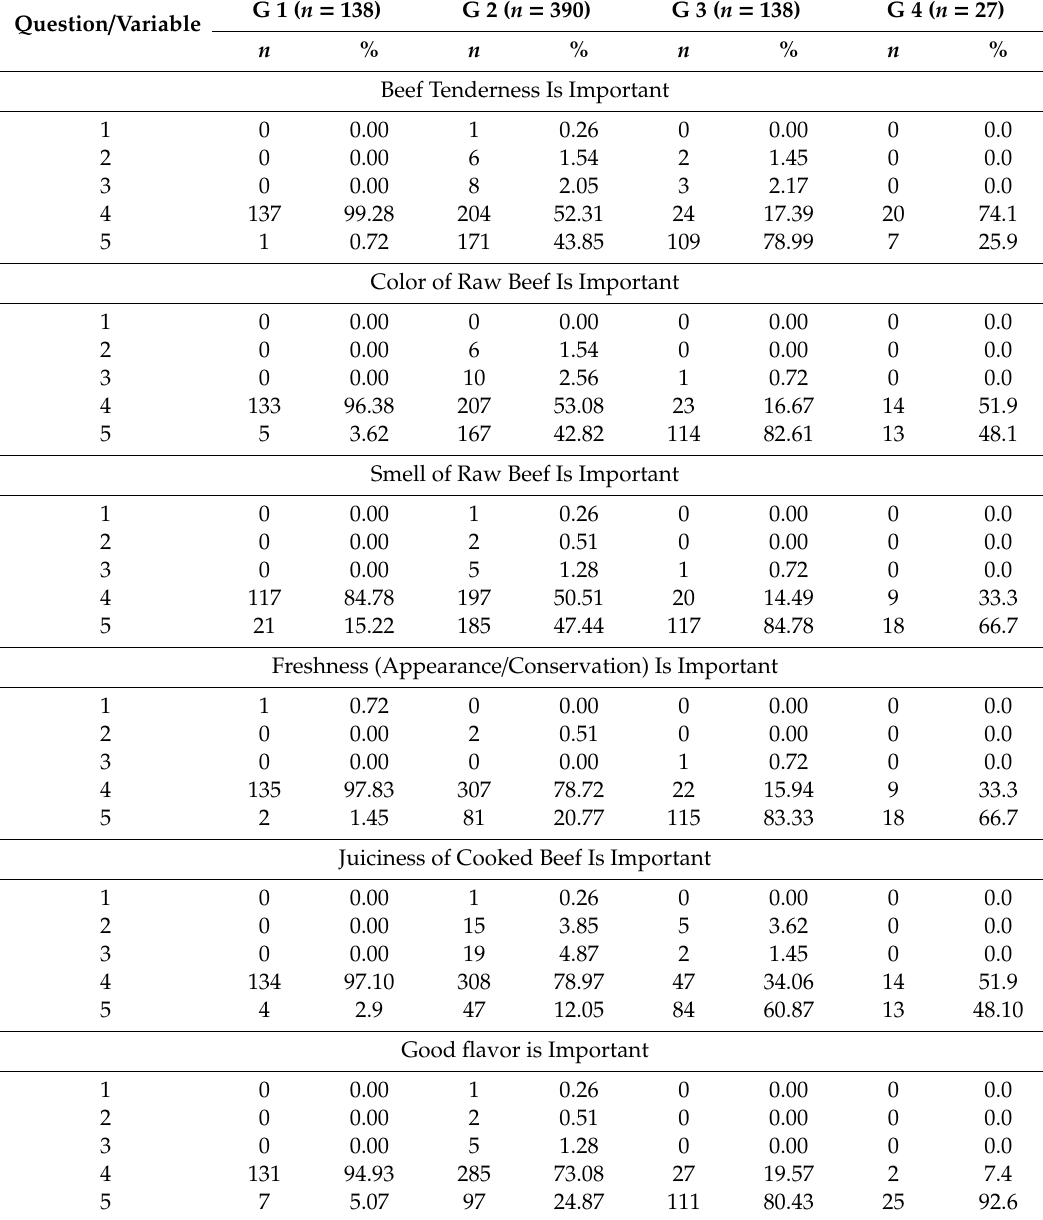
Table 4. Intrinsic attributes with significant di ff erences ( p < 0.05 *) in the groups of consumers identified by cluster